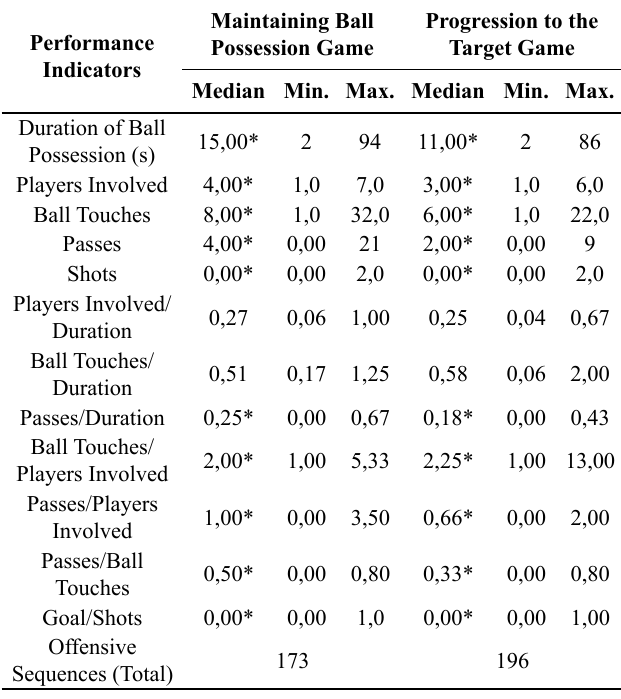
Progression to the Target Game